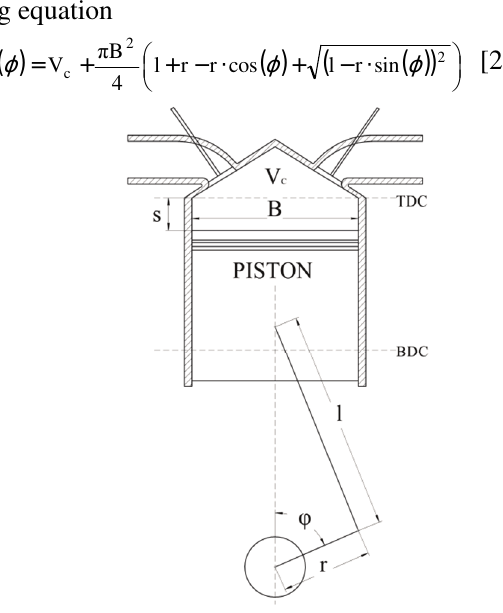
Fig. 1. Schematics of crank